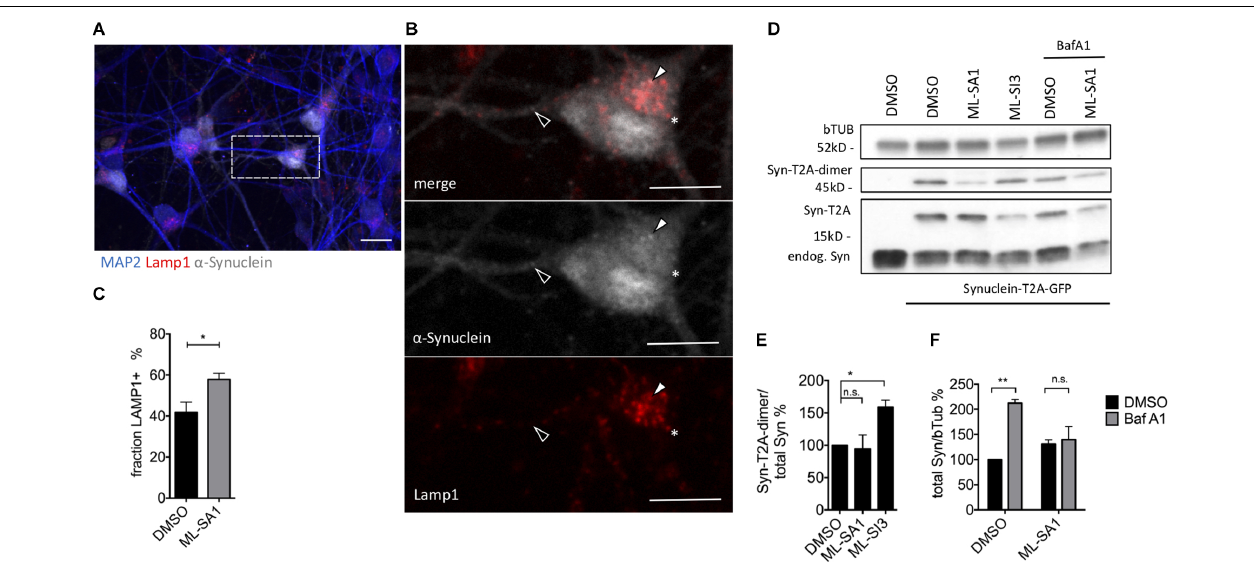
FIGURE 8 | Effect of TRPML1-agonist ML-SA1 and TRPML1-antagonist ML-SI3 on α -synuclein particles in iPSC-derived mature neurons. (A) Example images of NPC-derived neurons transduced with α -synuclein-T2A-GFP using lentivirus. Twenty-one days after transduction, cells were treated for 24 h either with 20 µ M ML-SA1 or DMSO. Cells were further stained against human α -synuclein, lysosomal marker Lamp1 and neuronal marker MAP2. The scale bar represents 20 µ m. (B) Close up of (A) . Closed arrowhead marks a α -synuclein-positive/Lamp1-negative particle, open arrowhead marks a α -synuclein-positive and Lamp1-positive particle, asterisk marks a α -synuclein-negative/Lamp1-positive lysosome. (C) Percentage of Lamp1-positive synuclein particles per cell. Results of at least 30 neurons per condition. Unpaired t -test depicted with respect to DMSO ( p = 0.01). (D) Representative immunoblot of lysates from transduced neurons on day 21, treated with DMSO, ML-SA1 10 µ M, or ML-SI3 10 µ M and additionally DMSO or 100 nM BafA1 for 2 h. Full blot shown in Supplementary Figure 6A . (E) Quantification of the Synuclein-T2A-dimer band relative to total synuclein load in n = 3 independent experiments as in (D) . One-way ANOVA showed significance ( p = 0.03). Results of Dunnet’s multiple comparisons test are depicted with respect to DMSO ( p = 0.03). (F) Quantification of Synuclein load relative to beta-Tubulin in n = 3 independent experiments as in (D) . Two-way-ANOVA showed significant interaction ( p = 0.03), Sidak’s multiple comparisons test is depicted with respect